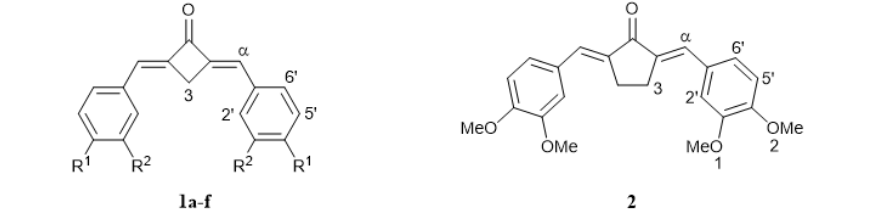
Figure 1. Structure of compounds 1a - f and 2 .